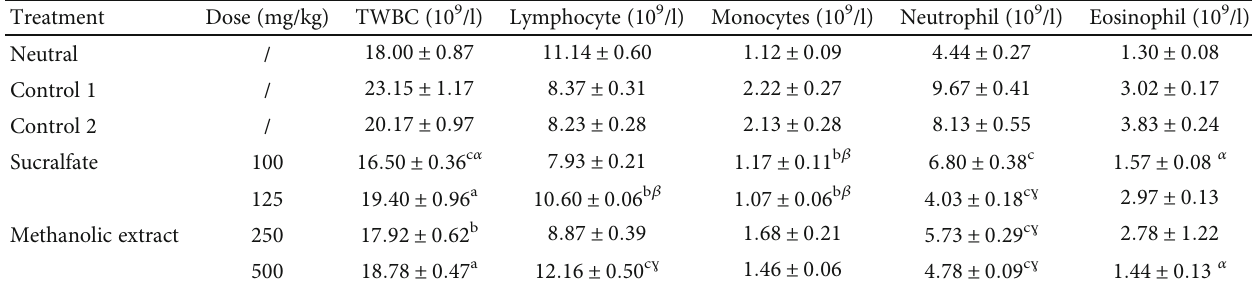
Figure 2: Macroscopic appearance of the gastric mucosa of the rats: (a) normal group: no lesions are observed; (b) ulcerated rats killed 5 days postethanol administration: severe lesions are seen in the gastric mucosa; (c) ulcerated rats (given indomethacin for 4 days + DMSO3% for 10 days): lesions are seen in the gastric mucosa with in fl ammation; (d) sucralfate (100mg/kg): lesions in the gastric mucosa are less than those observed in negative control groups; (e) (125mg/kg): less lesions; (f) (250mg/kg); (g) (500mg/kg): no lesions are observed; u: ulcer. Table 4: In fl uence of the methanolic extract of D. benthamianus stem bark on some hematological parameters in ethanol-induced gastric lesions in